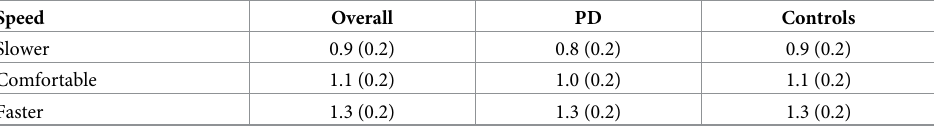
Table 2. Three walking speeds for the overall sample and persons with Parkinson’s Disease (PD) and controls. Speed